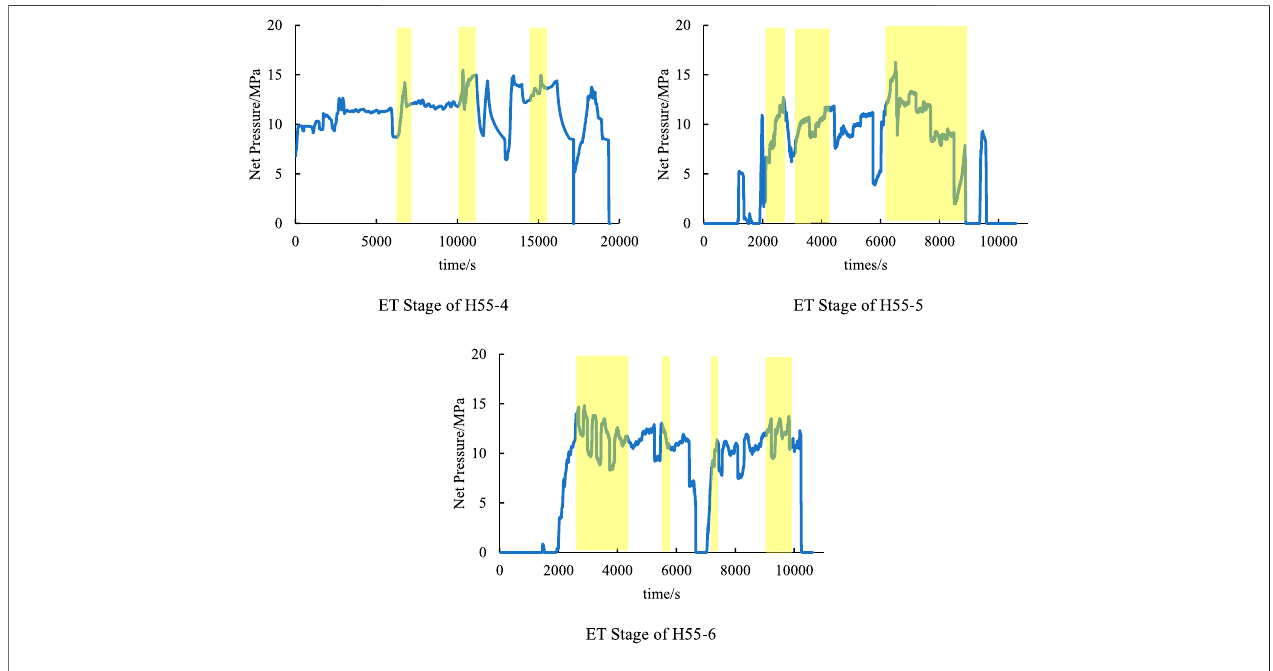
FIGURE 9 | Net pressure curve of ET stage in H55